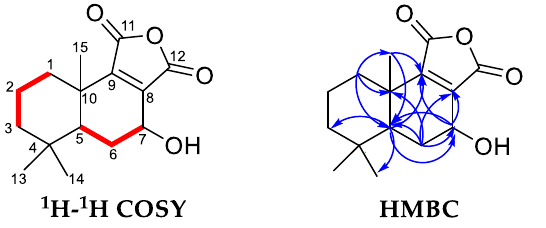
Figure 4. Key 1 H- 1 H COSY and HMBC correlations for compound 3 .